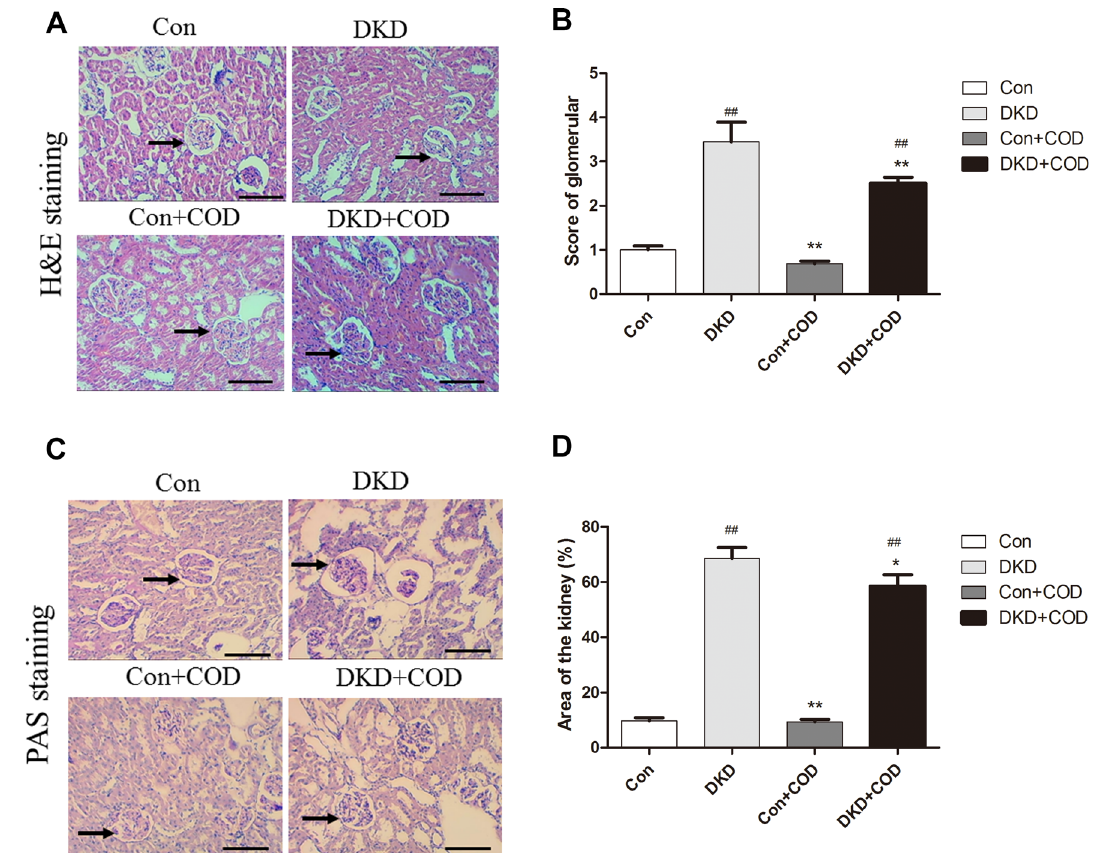
Fig. 3 Effect of COD on renal histopathological alterations in DKD rats. The photomicrographs of H&E-stained ( a ) and PAS-stained ( c ) kidney sections were obtained for the four groups on day 30. Scale bar: 600 l m ( 9 100). b Histopathological alterations in H&E-stained kidney slides were scored for the four groups on the basis of the semi- quantitative percentage of the damaged area on a scale from 0 to 4: 0,